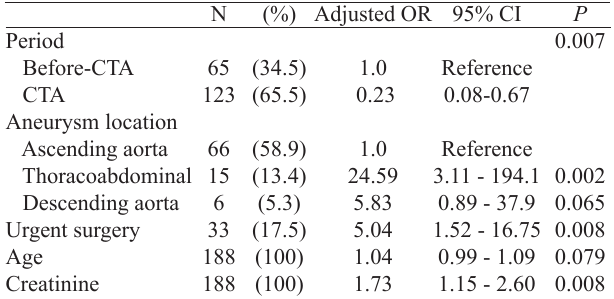
Independent predictors of in-hospital death in multivariable analysis are marked in bold letters. Logistic regression model was adjusted for the following covariates: period (CTA), aneurysm location, disease, type of dissection, reintervention, hemoglobin, aortic size and bypass time. OR=odds ratio; 95%CI=95% confidence interval.